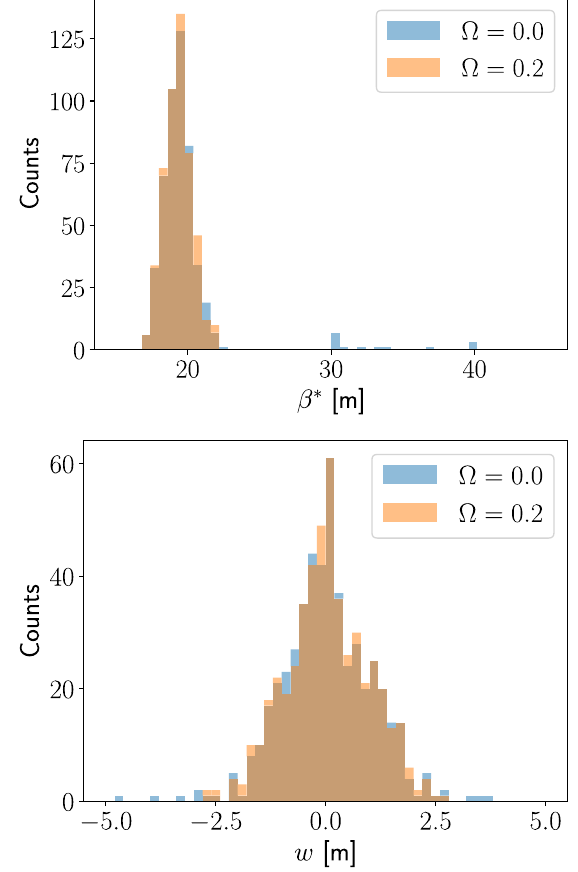
FIG. 8. Histogram of the reconstructed vertical β (cid:1) (top) and vertical waist (bottom) w using K modulation in IP1 for different values of the weight Ω